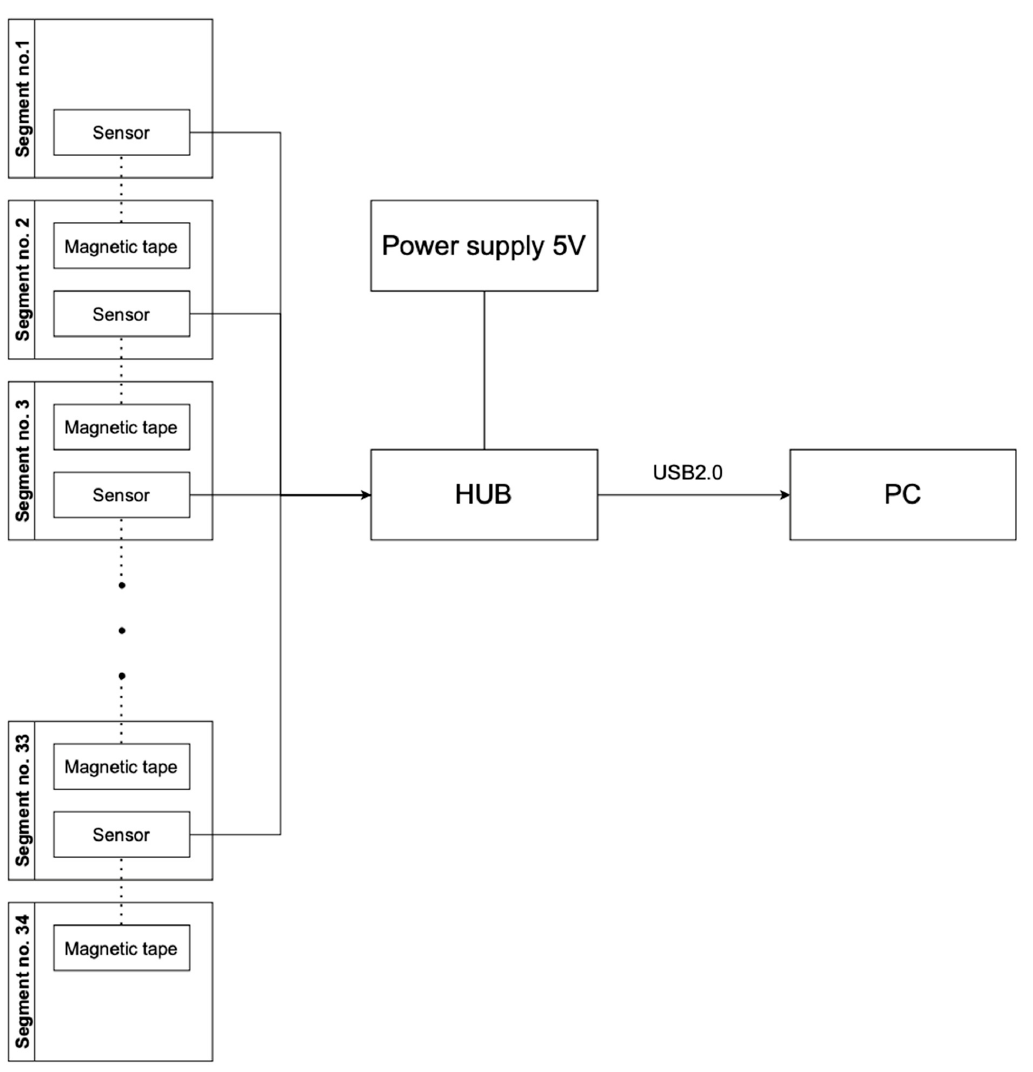
Figure 4. Information about the degree of rotation of each element is collected, via the Hall effect, by its sensor from the magnetic tape (3M ® ) strip located on the next adjacent element. The hub contains a power block, a USB communication block, sensor sockets, and a microcontroller. The information from the hub is analyzed via a Python-based application.